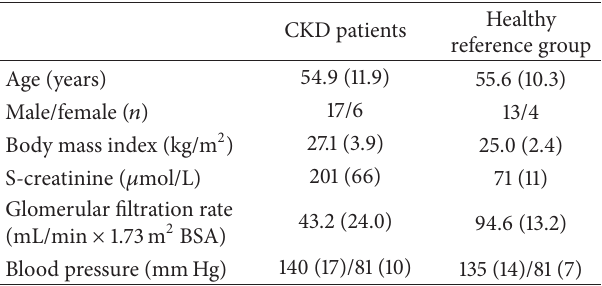
Table 1: Baseline characteristics of patient and reference groups. Mean and standard deviation (in